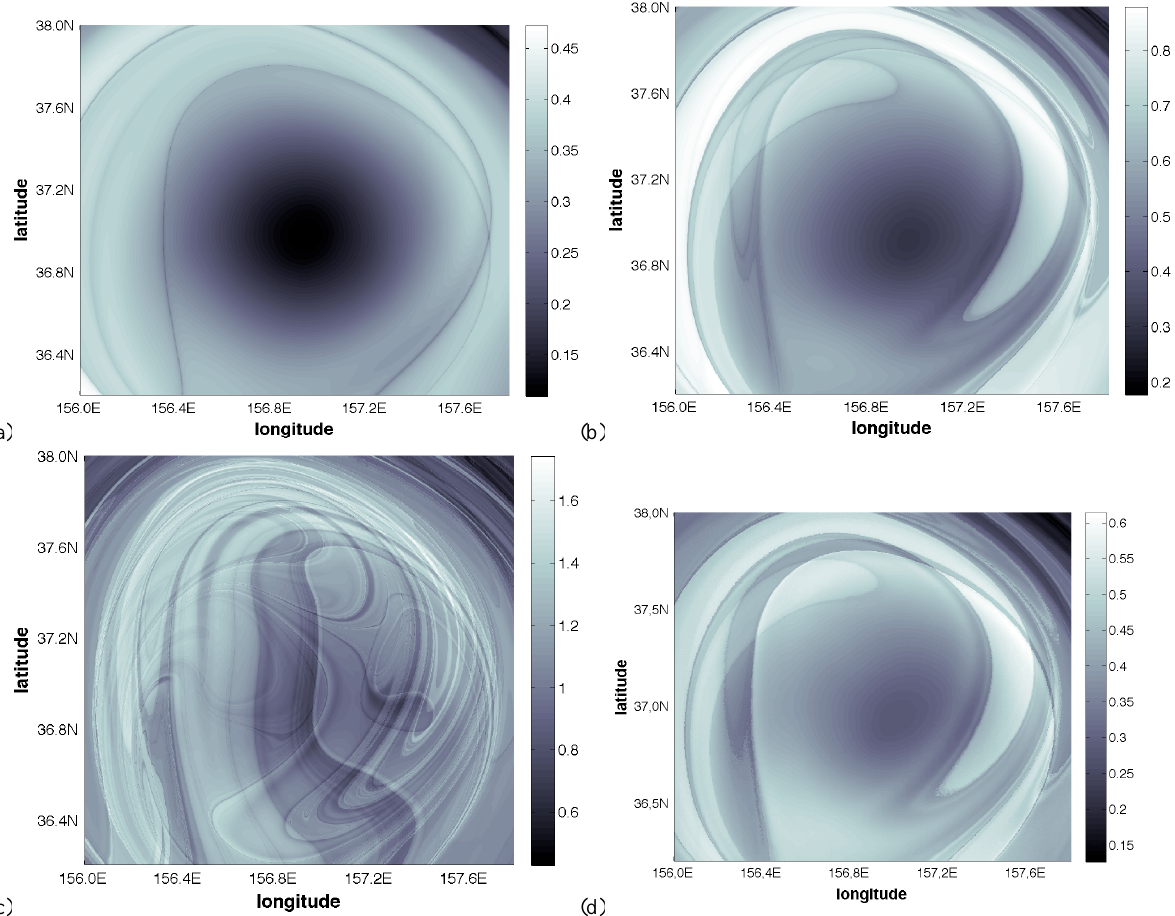
Fig. 5. Lagrangian structure of the inner core of the western eddy on 17 April for increasing τ values. (a) F ( x (t)) = || v ( x (t),t) || and τ = 15 days; (b) F ( x (t)) = || v ( x (t),t) || and τ = 30 days; (c) F ( x (t)) = || v ( x (t),t) || and τ = 72 days; (d) F ( x (t)) = || a ( x (t),t) || and τ = 30